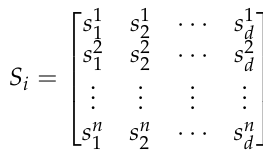
Figure 1. Single salp ( A ) and the salps chain ( B ). Algorithm 1 (SSA) is an evolutionary algorithm that was developed by Mirjalili [20]. The swarm S of n salps can be represented in Equation (1), where Foo is the source of food. The population of salps is represented by a matrix. Each row is a salp or solution. The length of the salp is the number of features in a dataset ( d ). The number of salps ( n ) is the swarm’s size. The first row in the matrix is the leader salp, and the other rows are for the follower